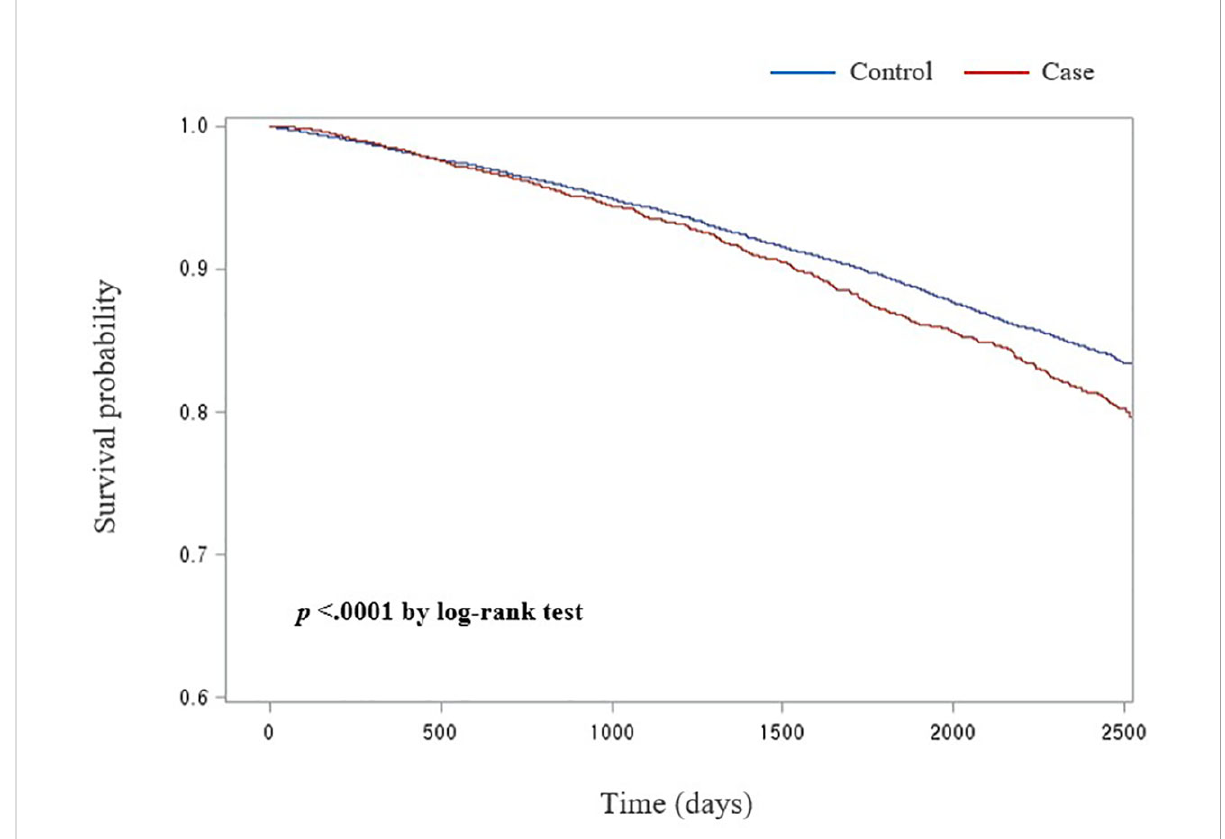
FIGURE 1 Kaplan-Meier curve for compare survival probabilities between case and control group.